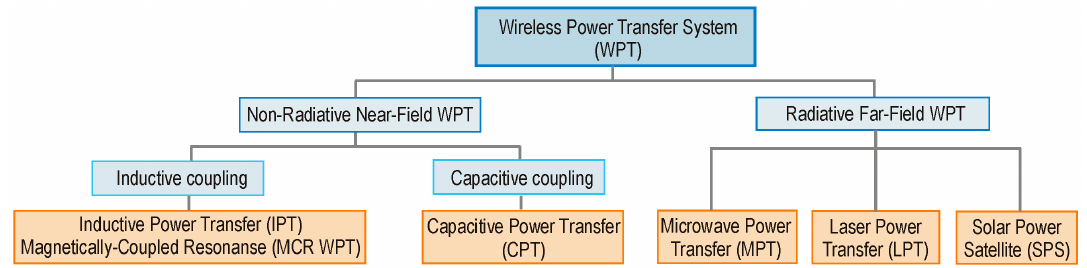
Figure 1. Classifications of the WPT system.